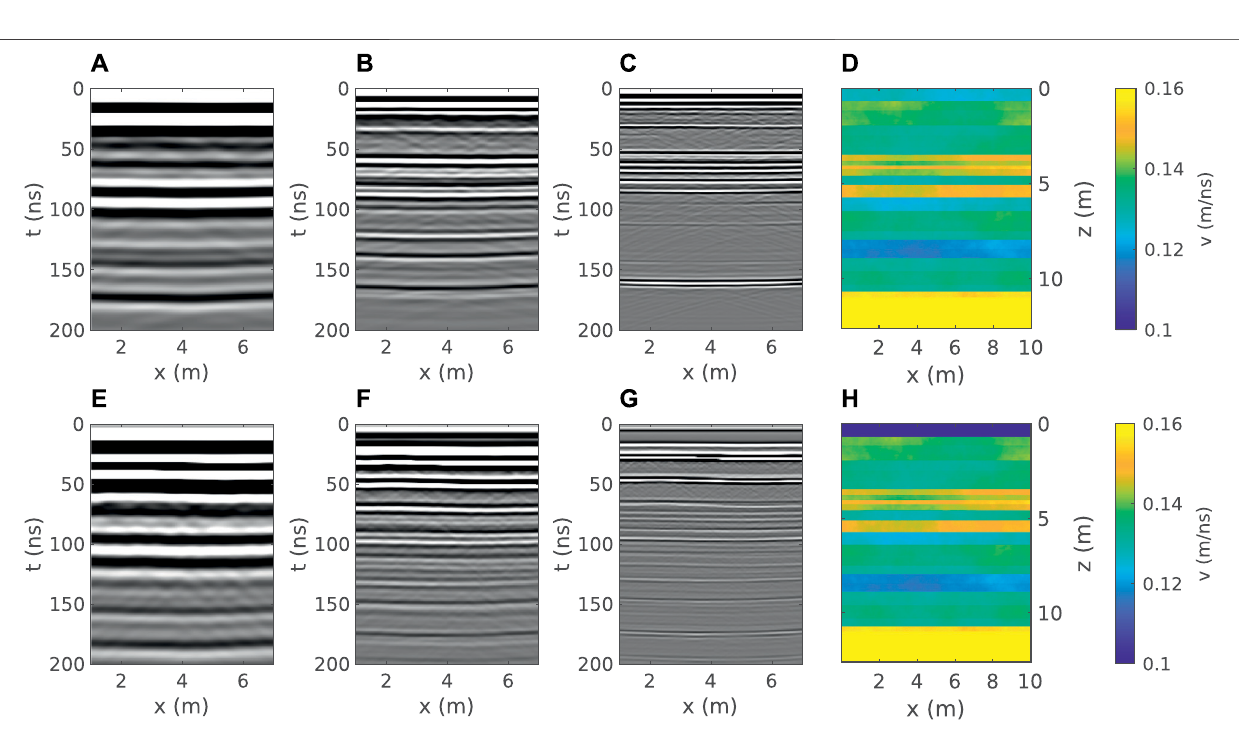
Frontiers in Earth Science |